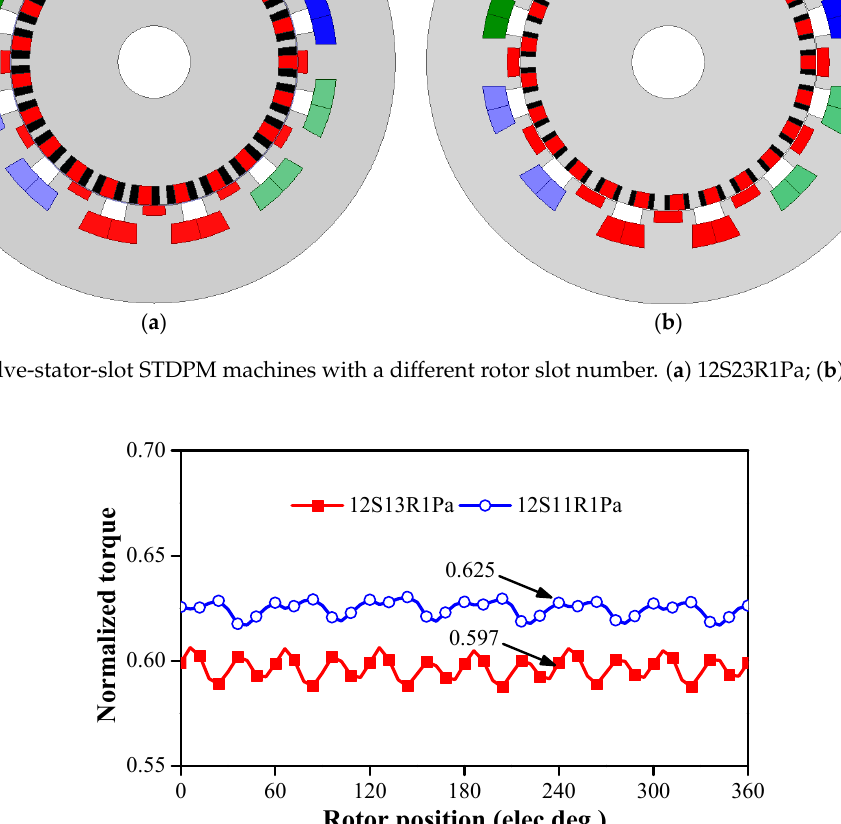
Figure 9. Torque waveforms of 12S1Pa SSDPM machines.